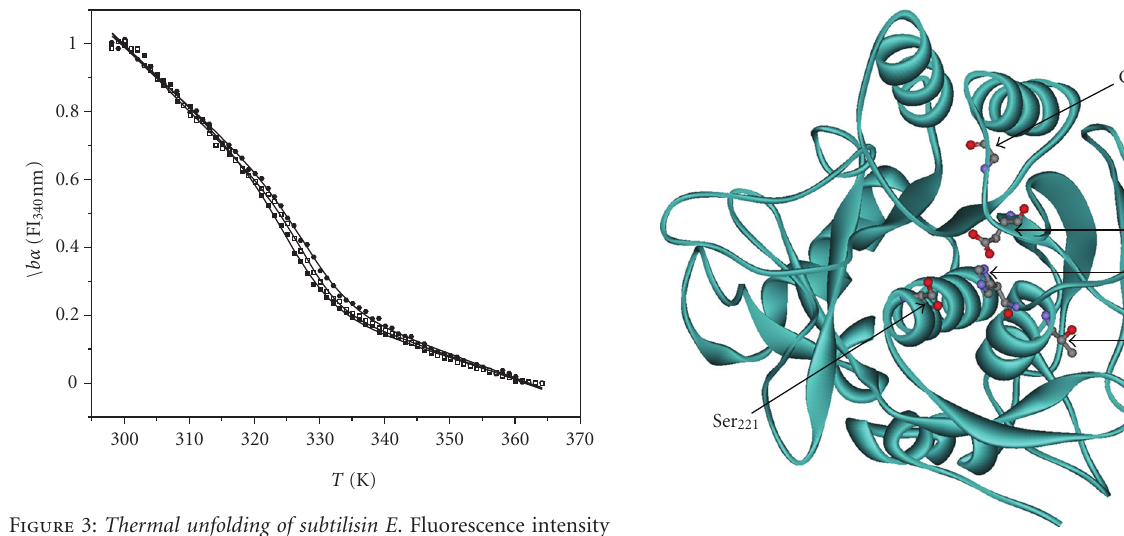
Figure 4: Ribbon diagram of the crystal structure of native subtilisin BPN (from coordinates obtained from [21]), drawn using the program Discovery Studio (http://www.accelerys.com/). Relative locations of the catalytic residues and mutations are